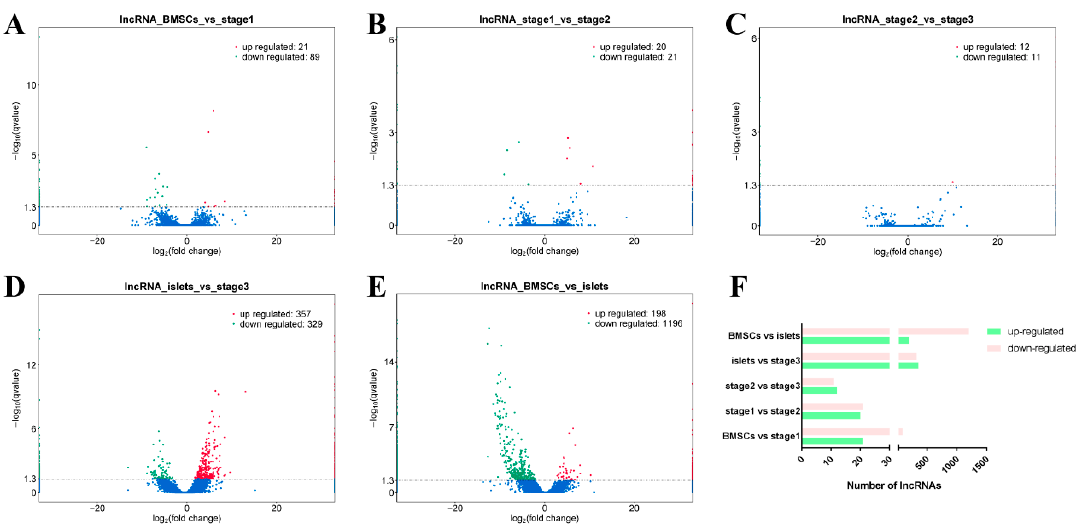
Figure 3. The volcano plot of differentially expressed lncRNAs of all comparison pairs: ( A ) For B vs. S1, there were 21 upregulated and 89 downregulated lncRNAs. ( B ) For S1 vs. S2, there were 20 upregulated and 21 downregulated lncRNAs. ( C ) For S2 vs. S3, there were 12 upregulated and 11 downregulated lncRNAs. ( D ) For I vs. S3, there were 357 upregulated and 329 downregulated lncRNAs. ( E ) For B vs. I, there were 198 upregulated and 1196 downregulated lncRNAs. ( F ) The statistics of all differentially expressed lncRNAs and the numbers were narrowed after induction.